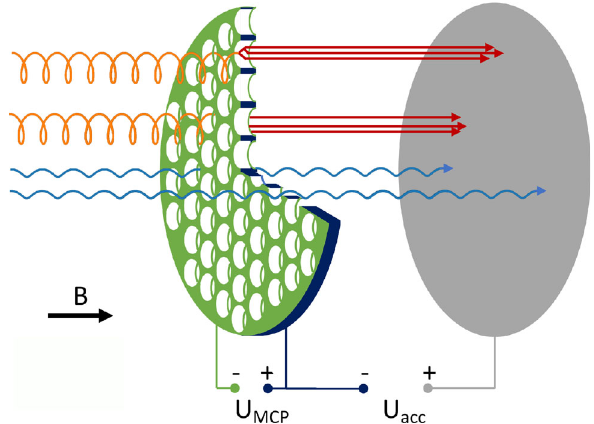
Fig. 2 Principle of an MCP-based active transverse-energy filter in front of an electron detector (gray) in a horizontal magnetic field B . Electrons with a small cyclotron radius (blue) pass the MCP without interaction in most cases, hit the detector and get counted there. These electrons giving rise to a standard energy deposition in the detector are considered to be mostly background electrons (see Fig. 1). Electrons withalargecyclotronradius(orange)havealargechancetohittheMCP walls since they possess significant pitch angles of typically ≥ 10 ◦ and possess incidence angles with respect to the MCP channel normal of typically ≤ 80 ◦ . Thus, they possess a large chance to give rise to a cascade of secondary electrons (red) that are accelerated via U acc to the detector and lead to a large signal there. In order to tag the primary electrons with large cyclotron radius – the goal of aTEF, those electrons producing large detector signals will be classified as signal electrons (see Fig.